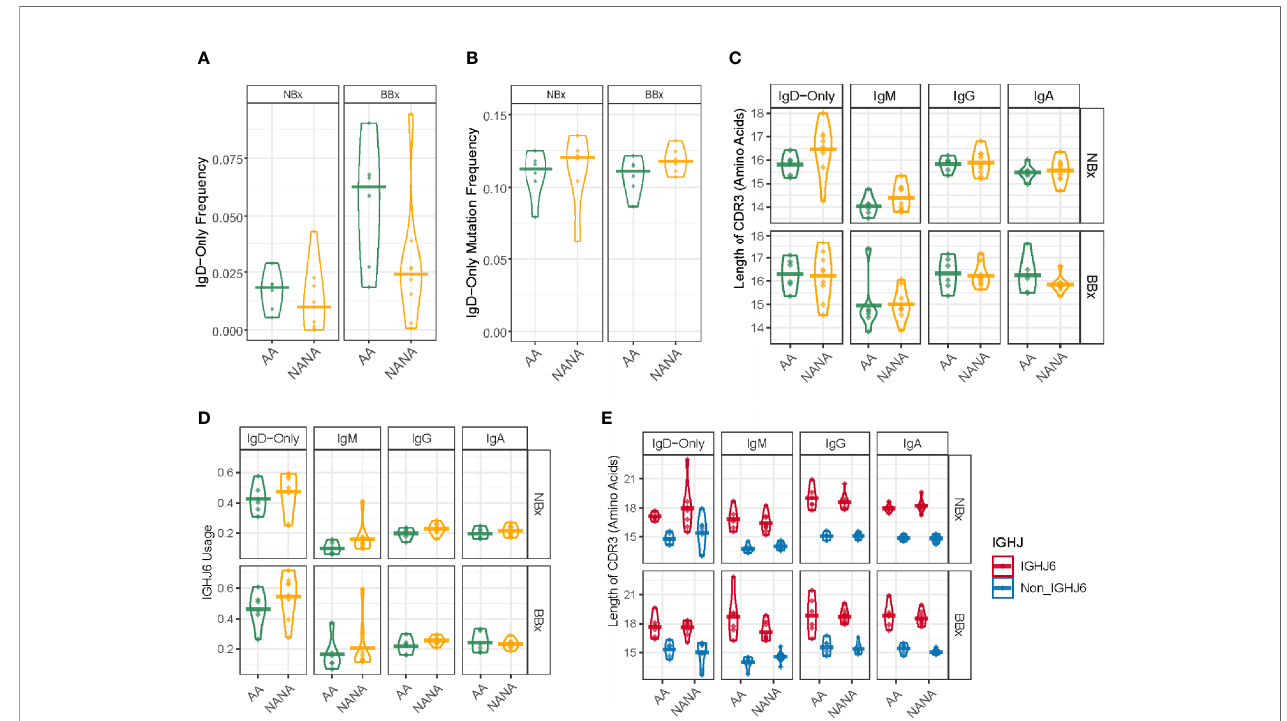
FIGURE 8 | Highly mutated IgD-only sequences with a long CDR3 region and a bias towards IGHJ6 are found in both the bronchial and nasal tissue. (A) IgD-only sequences are more commonly found in the bronchial mucosa (BBx) of atopic asthmatics (AA) compared to non-atopic controls (NANA). Lower frequencies of IgD-only sequences are seen in the nasal mucosa (NBx) of both subject groups. NANA03, 07 and 12 have been excluded from this and all subsequent analyses involving the IgD- only cell subset as they have too few IgD-only sequences (< 20 IgD-only sequences). (B) IgD-only sequences have a high rate of somatic hypermutation in both atopic asthmatics and non-atopic controls and both bronchial and nasal mucosa. No signi fi cant differences were found between groups. (C) The CDR3 lengths (given as the numbers of amino acids) of sequences belonging to each sequence type (IgD-only, IgM, IgG and IgA). Each dot represents the sequences from one individual. The IgD- only CDR3s were signi fi cantly longer than those from IgM sequences (p=0.05) except in bronchial biopsies from asthmatics which showed only a trend (p=0.067) but not compared to other isotypes (p>0.05 for all other comparisons). No signi fi cant differences were found between atopic asthmatics and non-atopic controls. (D) IGHJ6 is over-used in IgD-only sequences in both bronchial and nasal tissue (p<0.05 for all comparisons). Each dot represents an individual and the line is the mean for the group. (E) Sequences where divided into those using IGHJ6 or other IGHJ genes (Non_IGHJ6), which shows that the signi fi cantly longer CDR3 regions of IgD-only sequences compared to IgM sequences are found even in sequences using other IGHJ genes (blue) (p<0.05 in both the nasal and bronchial mucosa of atopic asthmatics). Each dot represents an individual and the line is the mean for the